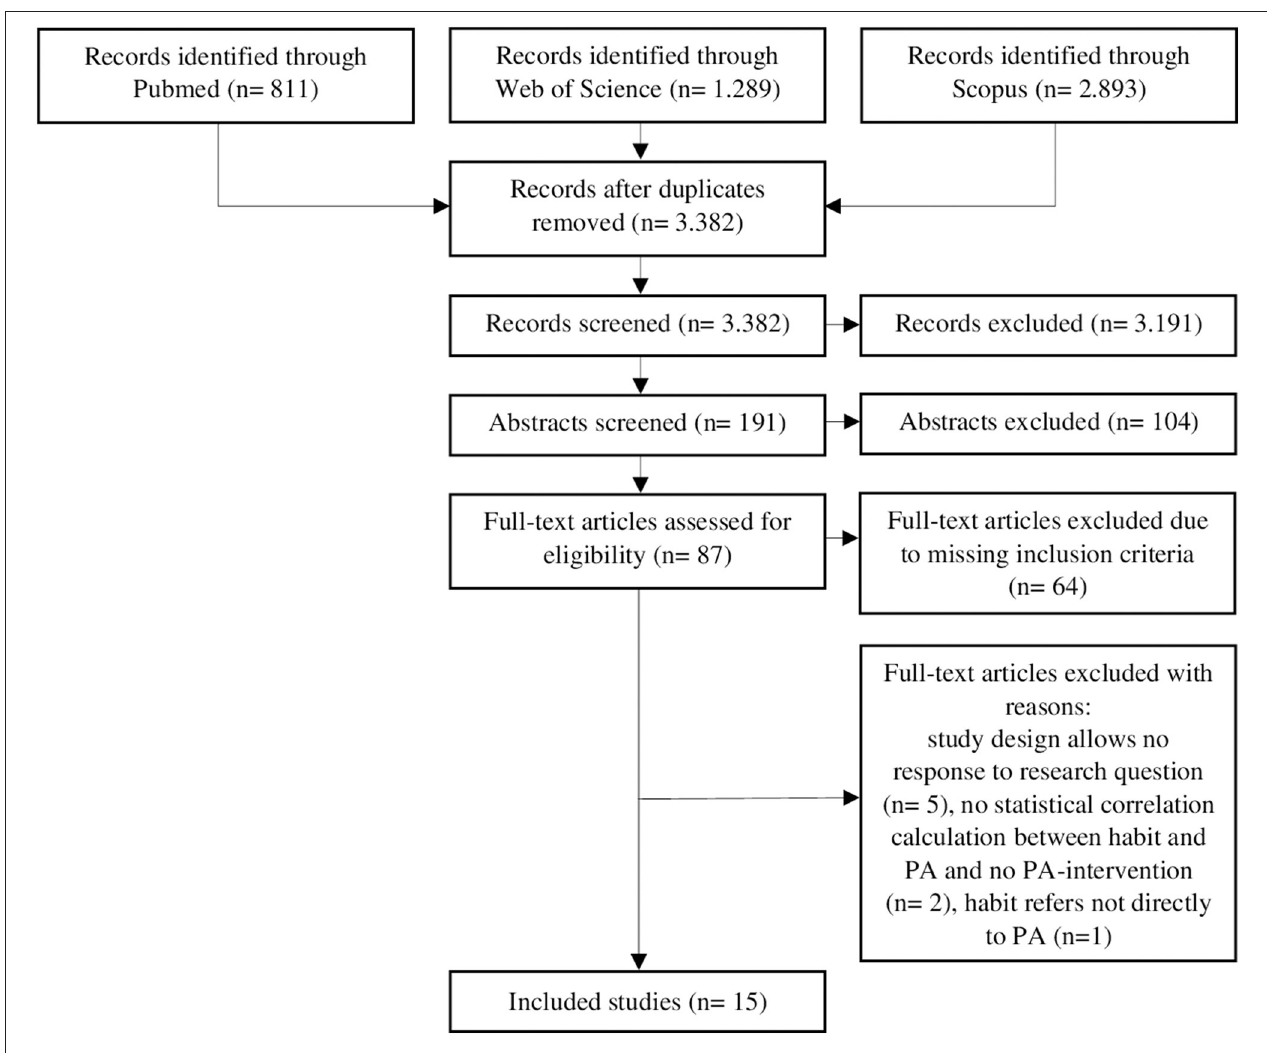
FIGURE 1 | Flow diagram of study selection process. PA: physical